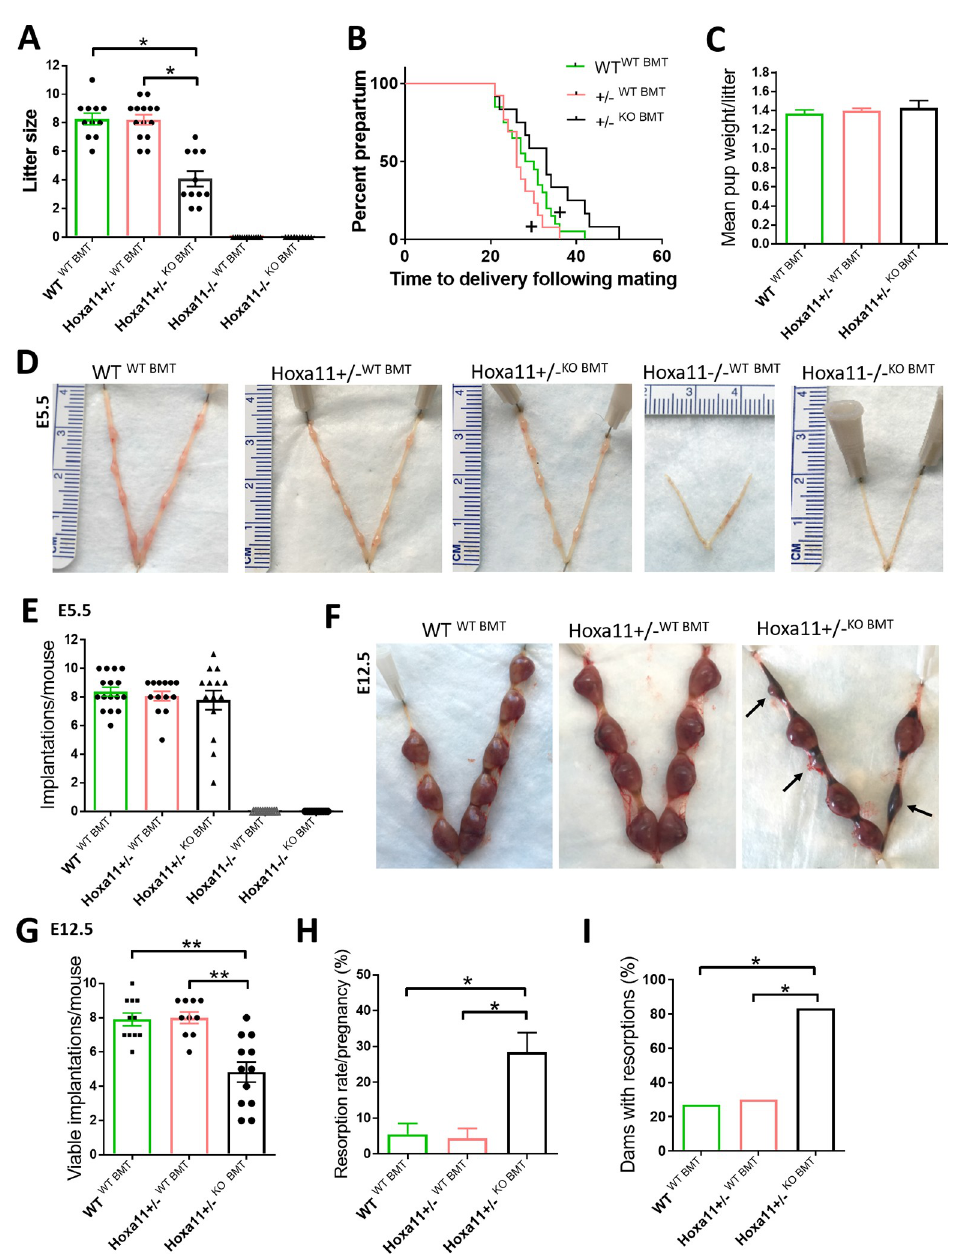
Fig 4. BM transplantation from WT donors prevents pregnancy loss in Hoxa11 +/ − mice. BMTs were performed from WT into Hoxa11 +/ − (Hoxa11 +/ − WT BMT ), WT into HoxA11 − / − (Hoxa11 − / − WT BMT ), Hoxa11 − / − into Hoxa11 +/ − (Hoxa11 +/ − KO BMT ), and HoxA11 − / − into Hoxa11 − / − (Hoxa11 − / − KO BMT ). WT mice receiving BMT from WT donors (WT WT BMT ) served as controls. (A-C) Effect of BMT from different genotypes on (A) litter size, (B) time to delivery, and (C) mean pup weight per litter following breeding ( n = 11–15/group). � p < 0.01. + p < 0.05 versus Hoxa11 +/ − KO BMT . (D and E) Representative uterine images (D) and quantitation of mean number of implantations per mouse on E5.5 (E) in WT, Hoxa11 +/ − , and HoxA11 − / − mice that received BMT from either WT or KO donors ( n = 10–16/group). (F-I) Pregnancy resorptions on ED 12.5 in WT and Hoxa11 +/ − mice that received BMT from either WT or KO donors ( n = 10–12/group). (F) Representative images of uteri showing resorption sites (black arrows). (G) Mean number of viable implantations per mouse. (H) Resorption rate per mouse pregnancy. (I) Percentage of dams with at least one resorption. In all panels, bar graphs represent mean ± SEM. � p � 0.05, �� p � 0.01. Underlying data are available in S1 Data. BM, bone marrow; BMT, BM transplant; Hoxa11, Homeobox a11; KO, knockout; WT, wild- type.